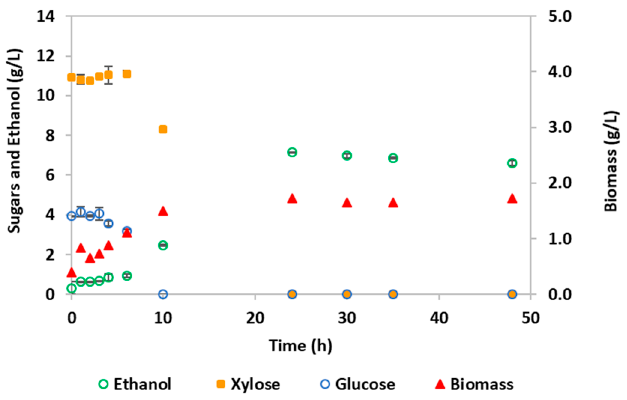
Figure 3. Time course of E. coli MS04 fermentation using the hydrolysate detoxified by membrane nanofiltration: glucose, xylose, bioethanol and biomass concentrations (45 mL, 150 rpm, initial pH 7 and 37 °C).